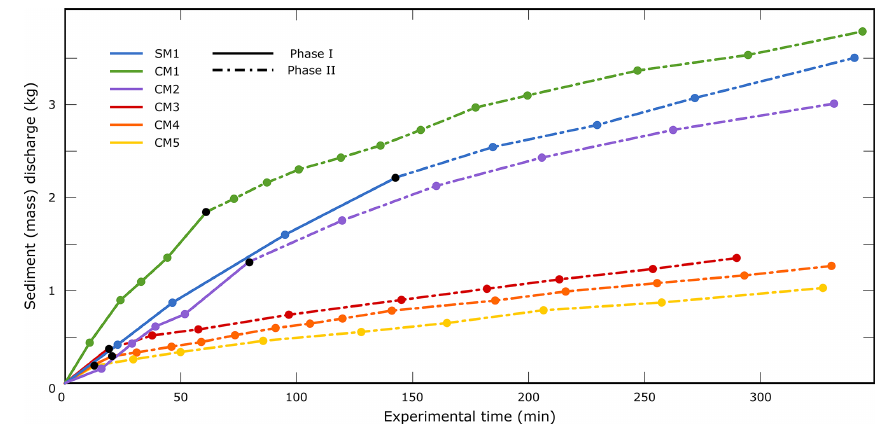
Figure 8. Cumulative mass (sediment) discharge over time for the six experiments. The solid lines correspond to phase I, while dashed lines correspond to phase II. The black dot highlights the transition from phase I to phase